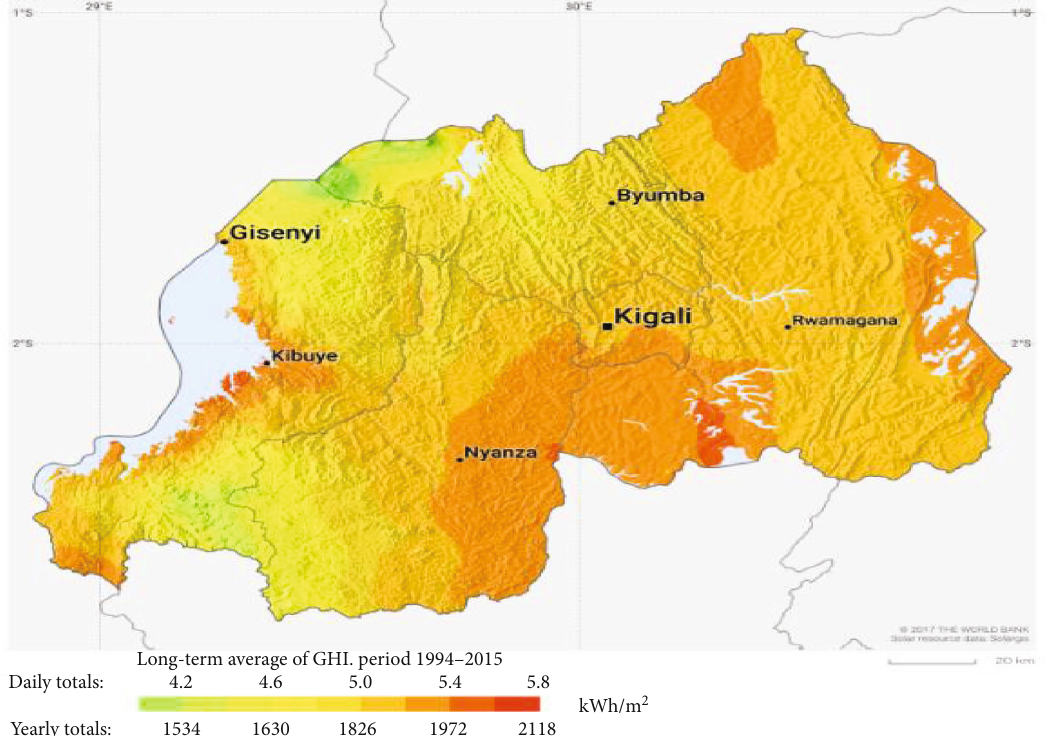
Figure 1: Global horizontal irradiation for Rwanda (1534-2018)